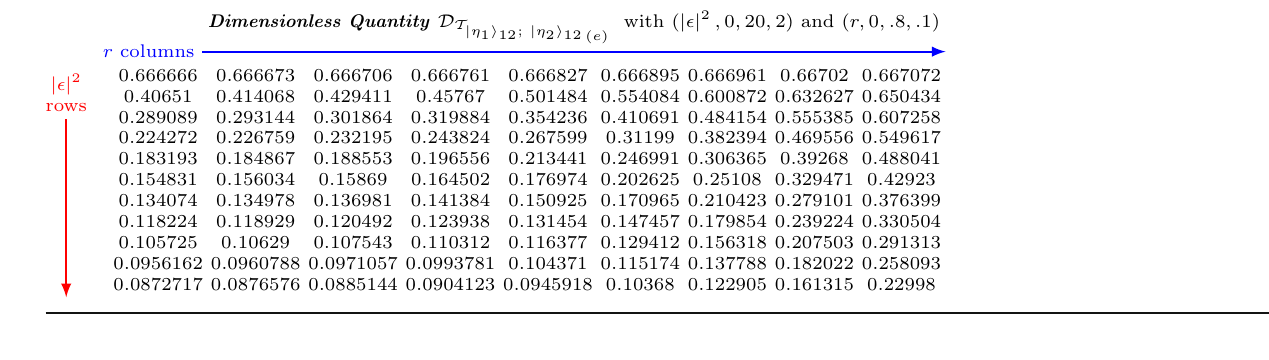
Table 8 Numerical values of D T for some range and choices of coherent and squeezing parameters. Here, | (cid:11) | 2 takes on value from 0 to 20 and r varies from 0 to 1